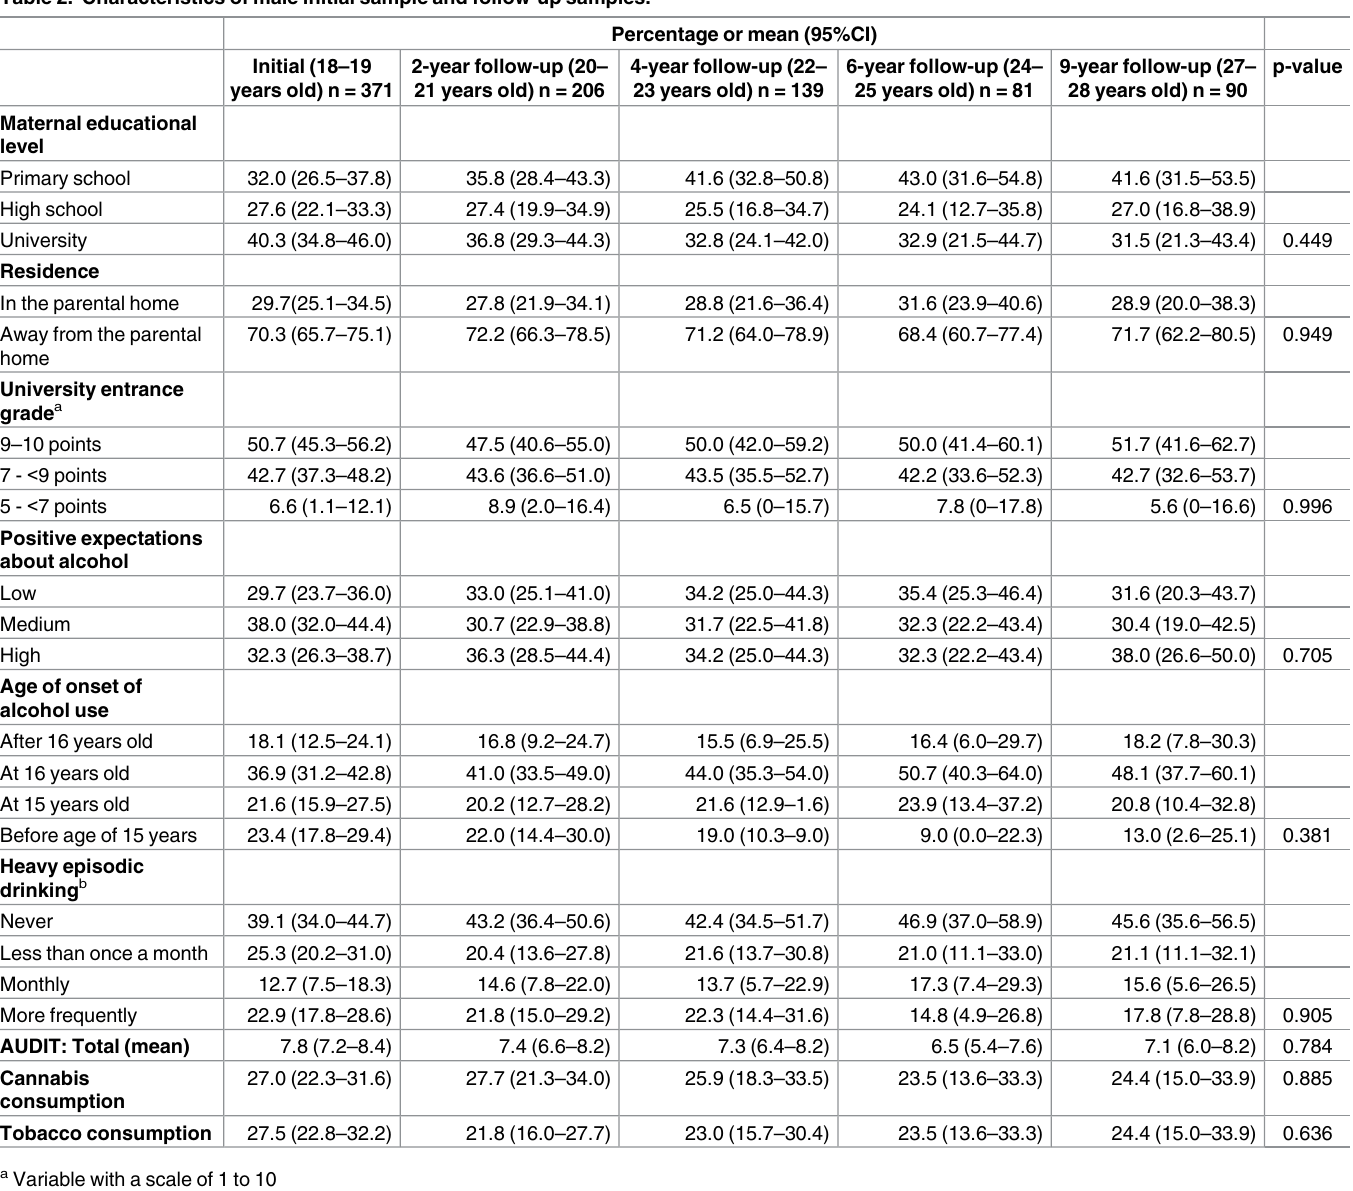
Table 2. Characteristics of male initial sample and follow-up